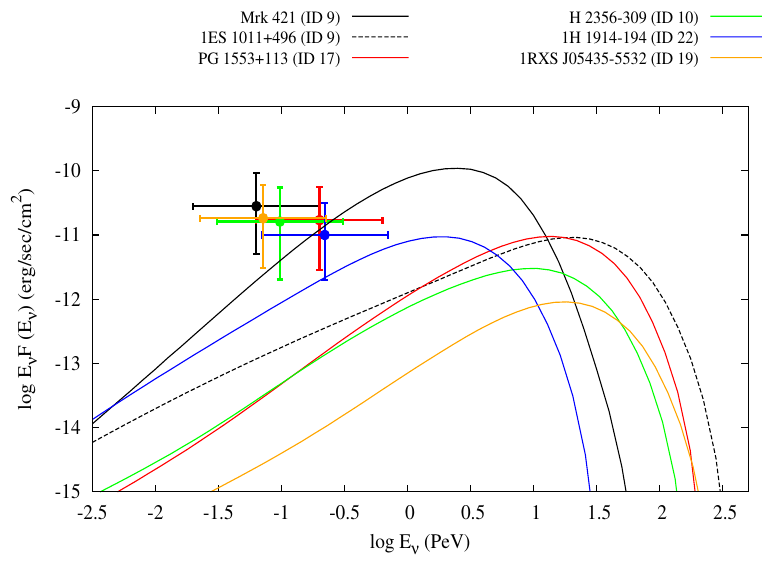
Figure 4. Comparison of the model (lines) and the observed (circles) neutrino fluxes as defined in [17] for the six BL Lacs of the sample. The Poissonian 1 σ error bars for each event are also